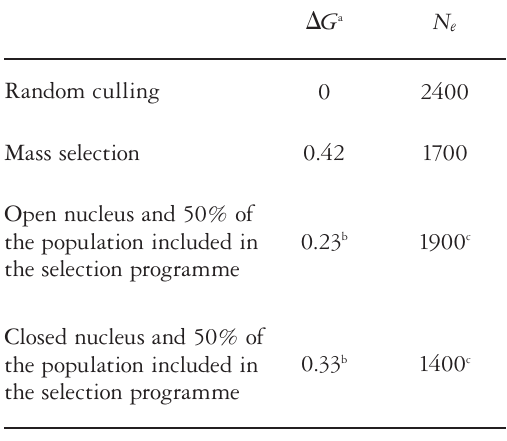
to uphold a viable population with sustainable gene- Table 3. Summary of annual genetic gain (  G ) and tic variation in the long term (Franklin, 1980; Mace effective population size ( N e ) for the four cases modelled. The age and sex structure are the same in all four cases (see methods